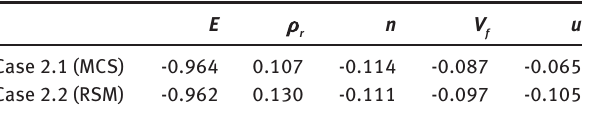
Table 5 Five most sensitive linear correlation coefficients between the RIPs and the CDOCE in case